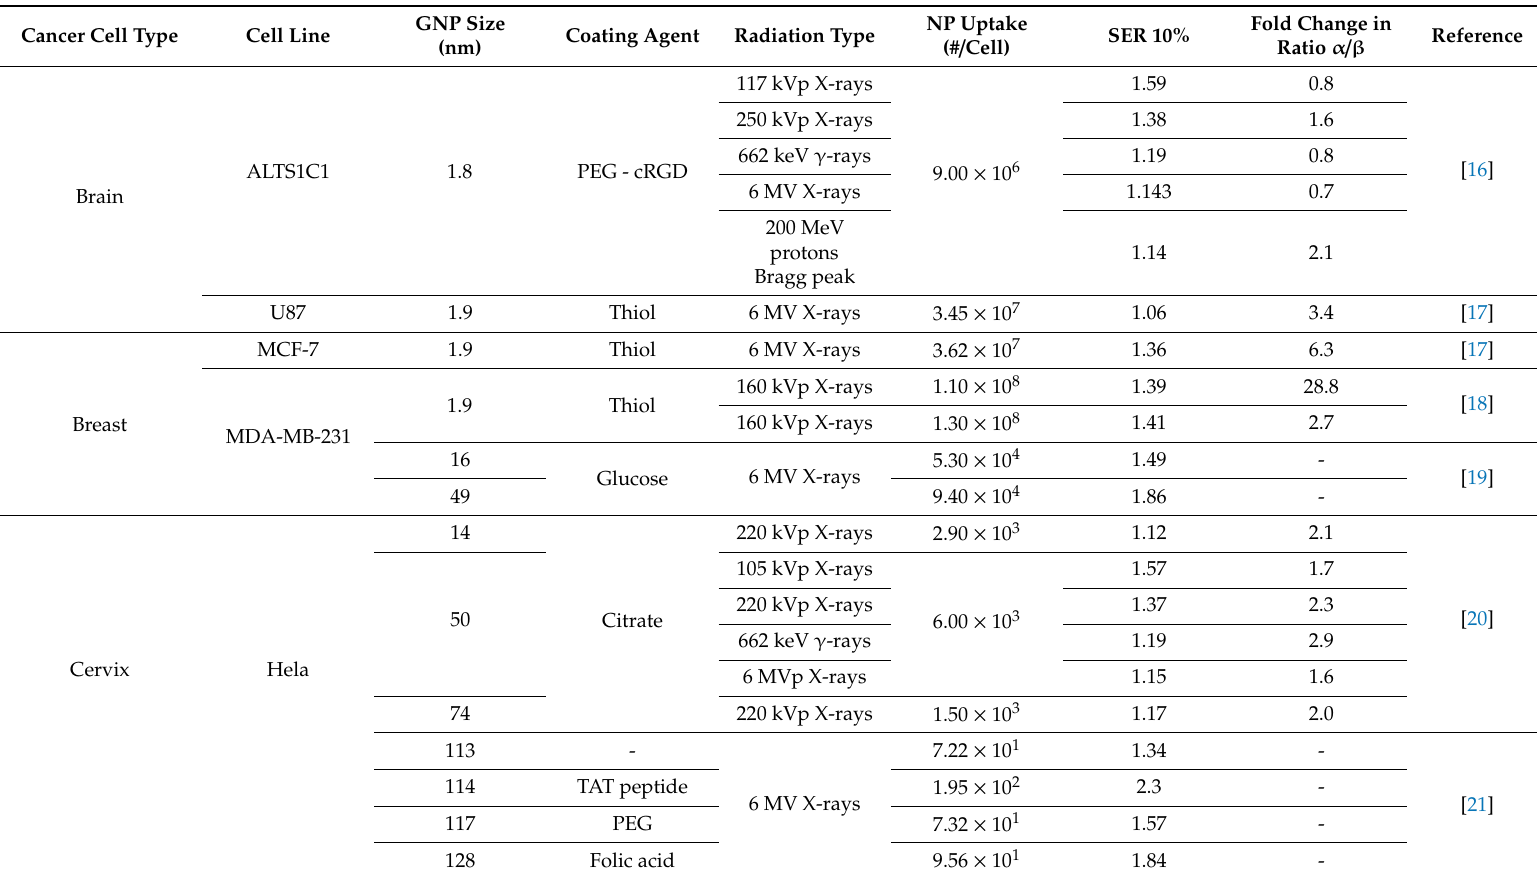
Table 1. Non-exhaustive list of in vitro studies of cell death enhancement by gold nanoparticles (GNPs). Only the studies that reported GNP cell uptake data and cell survival curves were selected. The results are alphabetically listed for the cancer type. The Sensitization Enhancement Ratio at 10% survival (SER 10% ) values were calculated from reported experimental data available in the corresponding publication / supplementary information. Fold change ratio in α / β is defined as the ratio of α / β from sample of interest (irradiated with GNPs) on α / β from control sample (irradiated without GNPs). An increase in fold change indicates a higher α / β when GNP are present during cell